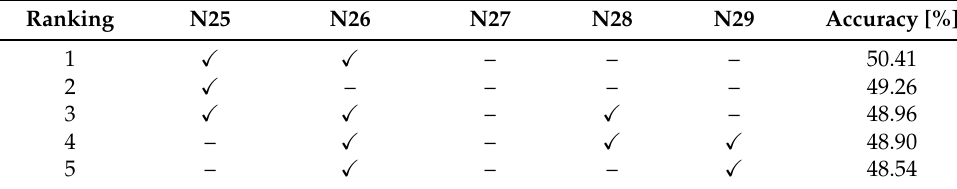
Table 14. Top five recognition accuracies of the added processing nodes.